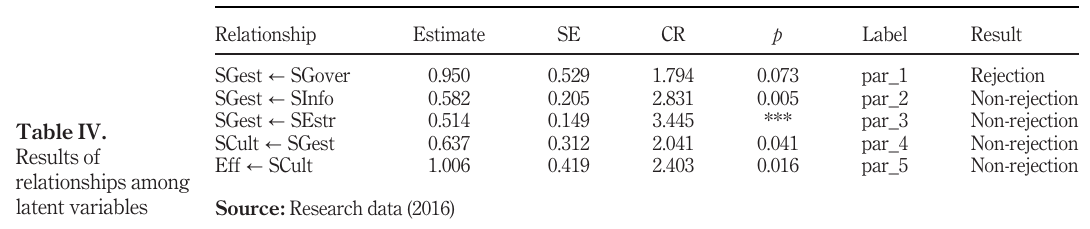
Table IV. Results of relationships